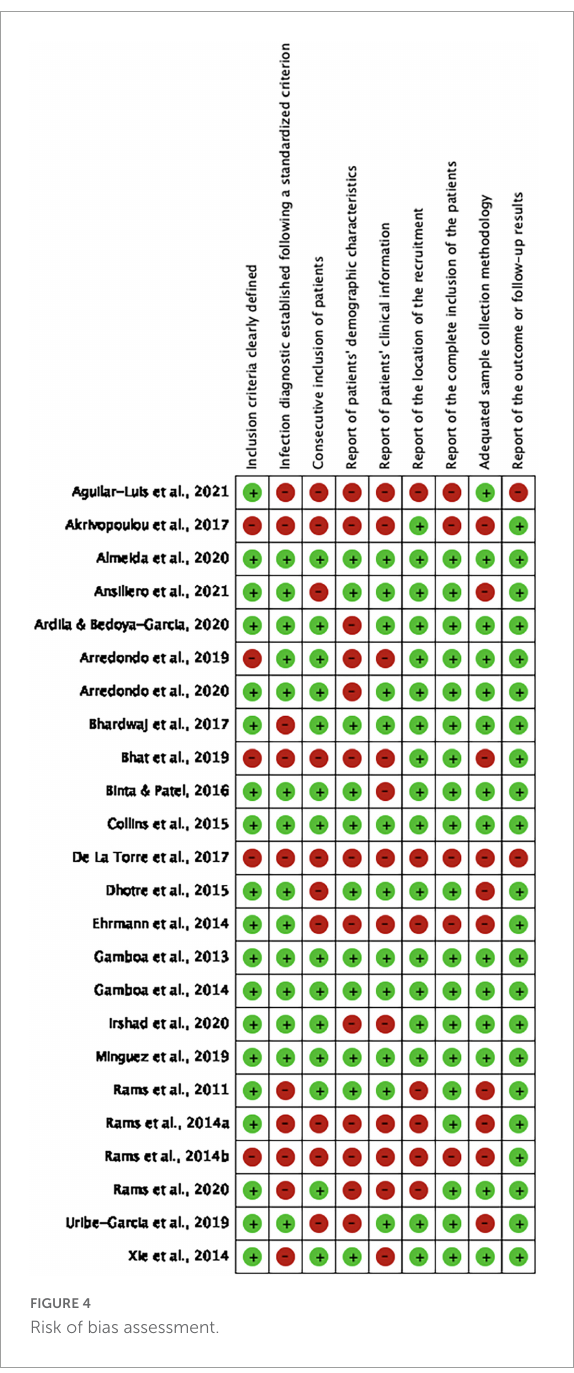
Arredondo et al., 2019, 2020; Uribe-Garcia et al., 2019; Ansiliero et al.,